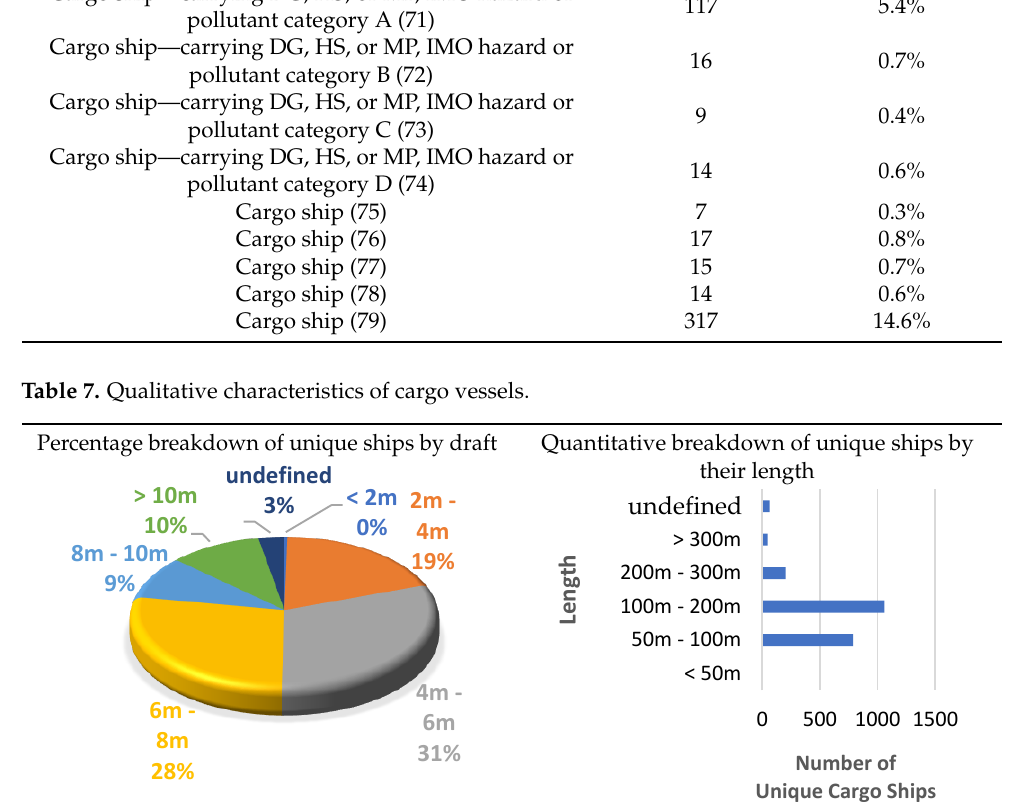
Table 6. List of unique passenger ships staying in the waters in 2017, broken down by type.